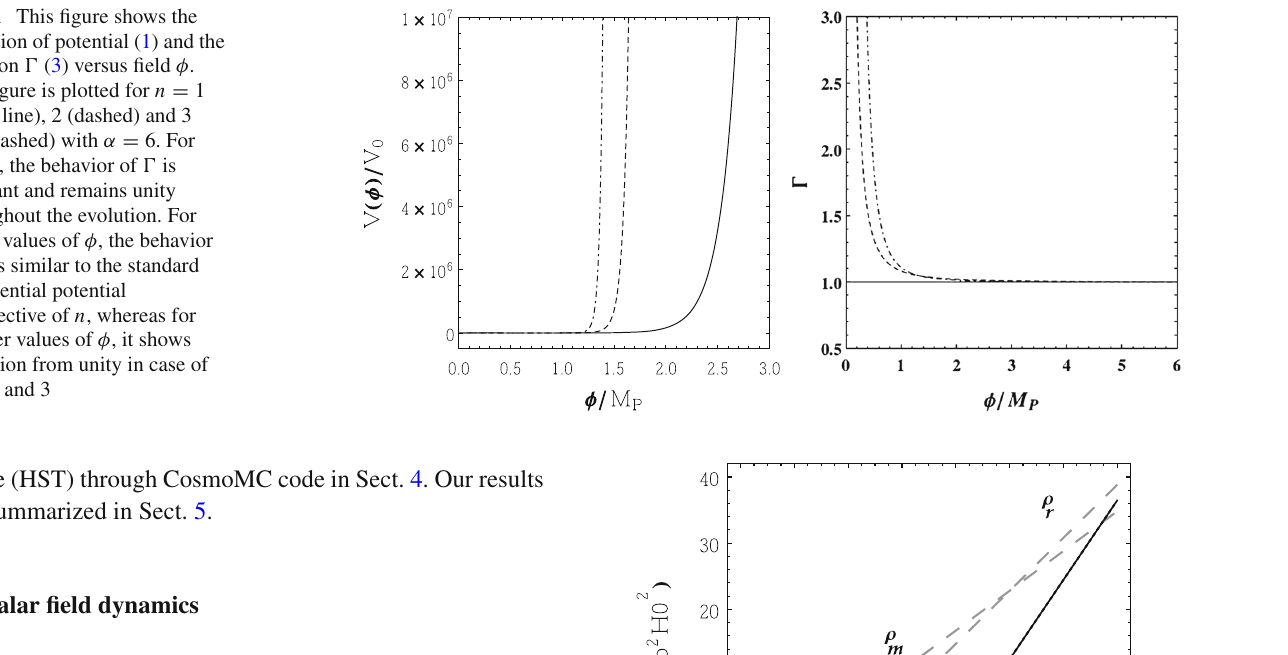
tial. The evolution of (cid:3) versus field for various values of n is displayed in the right panel of Fig. 1. From this figure, for n = 1, one can clearly see that the evolution of (cid:3) is